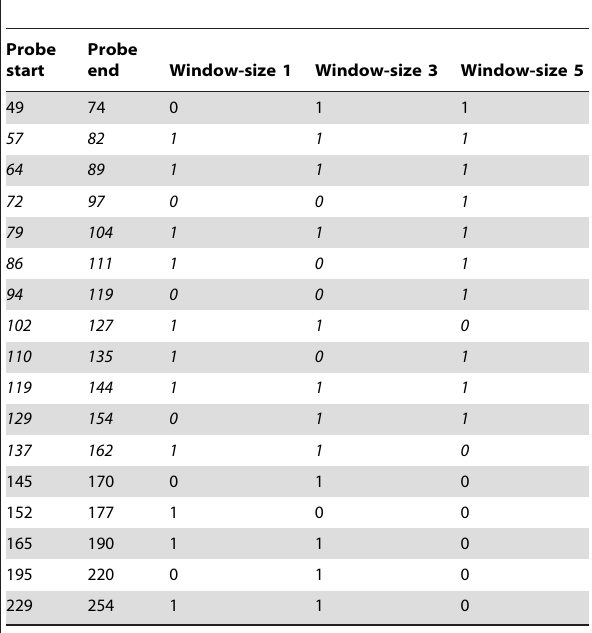
A strand-wise score matrix generated by the sliding window algorithm. The example is fictional and illustrates different examples of how the algorithm expands a differentially expressed region. The region from 57 to 162 ( italics ) will be detected as differentially expressed, while the rest are non-differentially expressed regions.